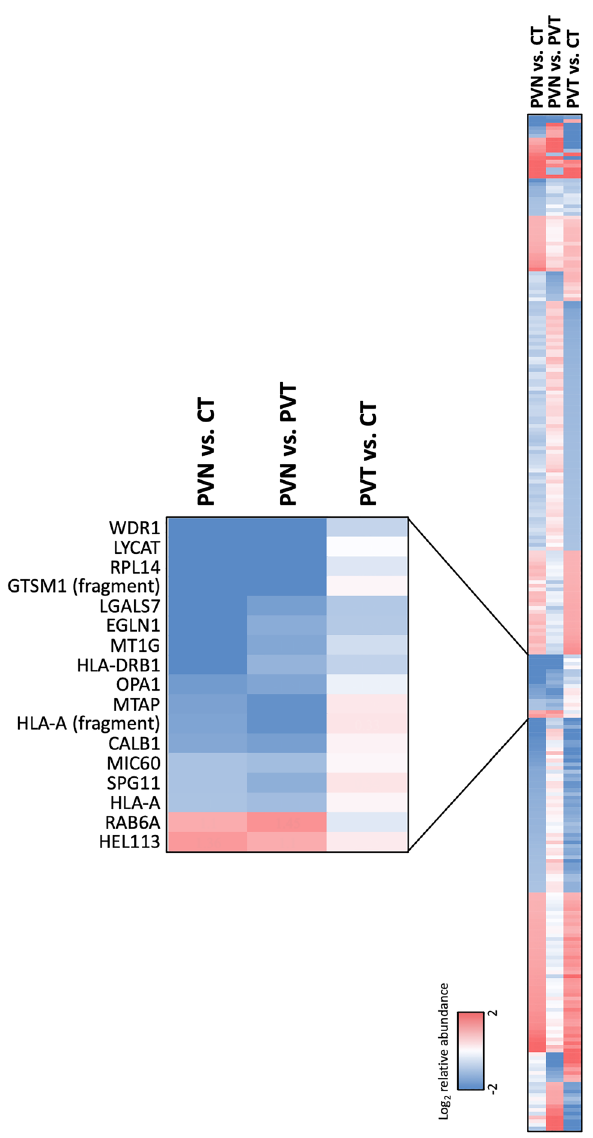
Figure 3. Expression heatmap of the differentially expressed proteins. TMT labelling and nano-LC MS/MS were performed on the pooled protein samples prepared from erythroblasts on day 7 in culture. Expression levels of identified proteins were compared across CT, PVT, and PVN. Proteins higher or lower expressed two or more-fold in PVN vs. CT, PVN vs. PVT, or PVT vs. CT comparisons were plotted on the heatmap, magnified area demonstrated 17 differentially expressed proteins in both PVN vs. CT and PVN vs. PVT comparisons but not in the PVT vs. CT